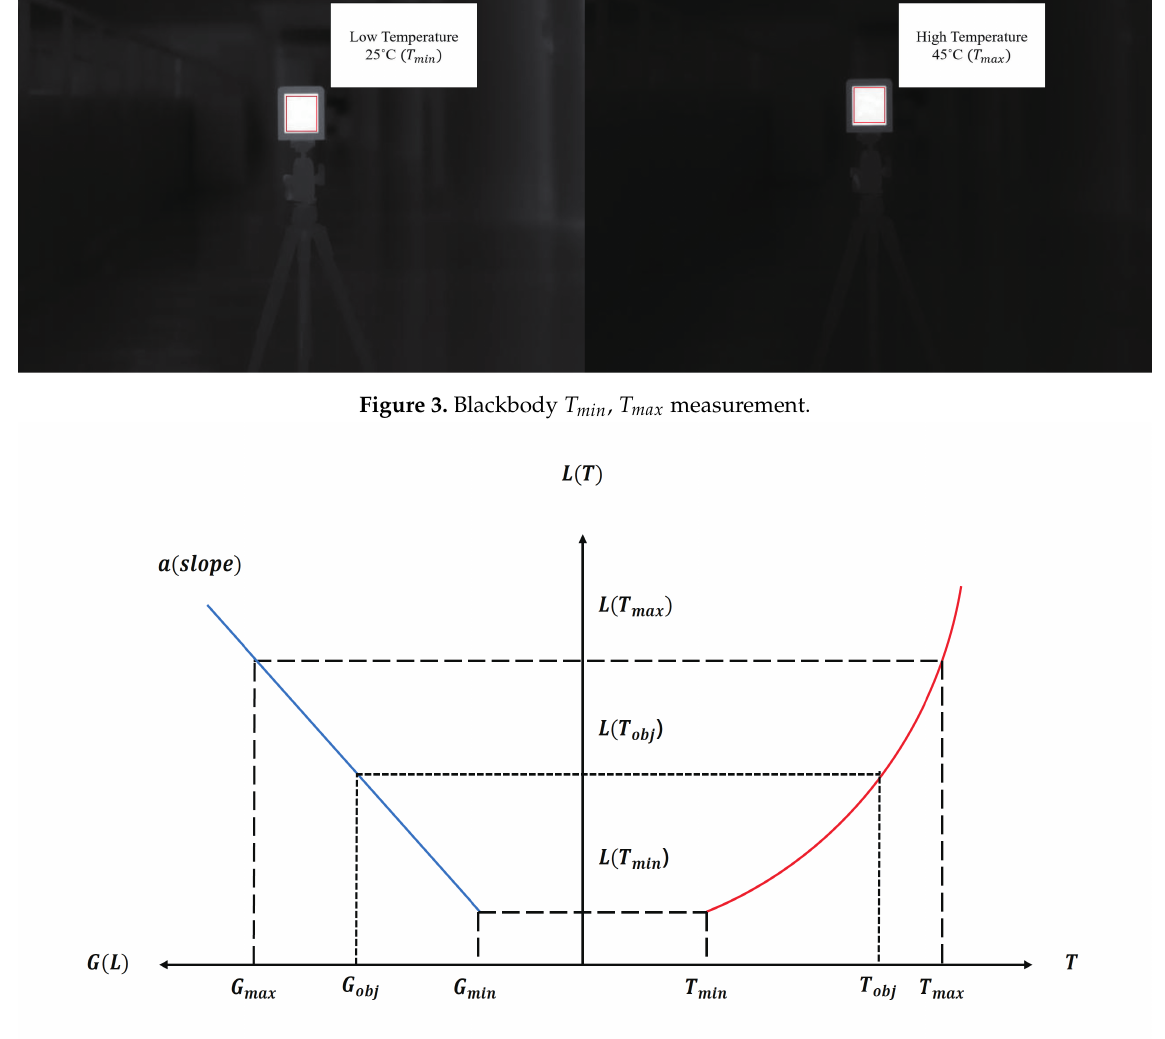
Figure 4. Relation curve of temperature and radiation, radiation and digital